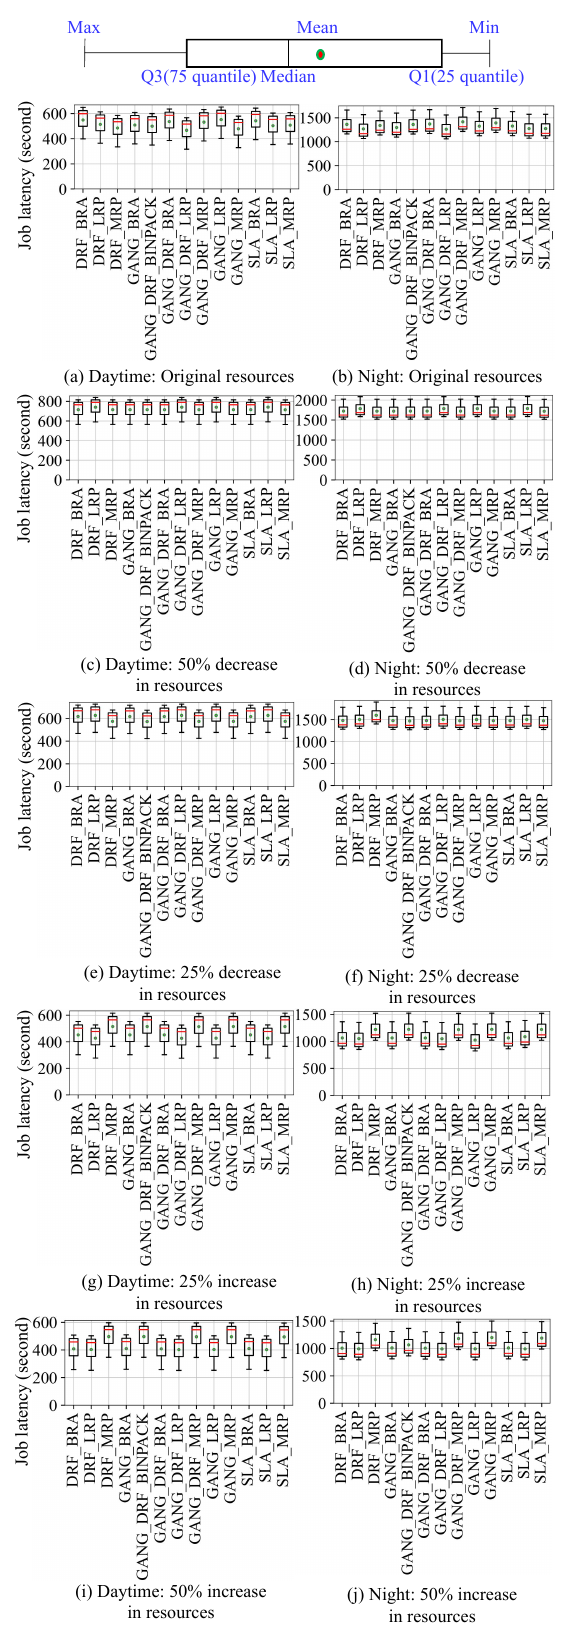
Figure 11. Real cluster: JobQueue